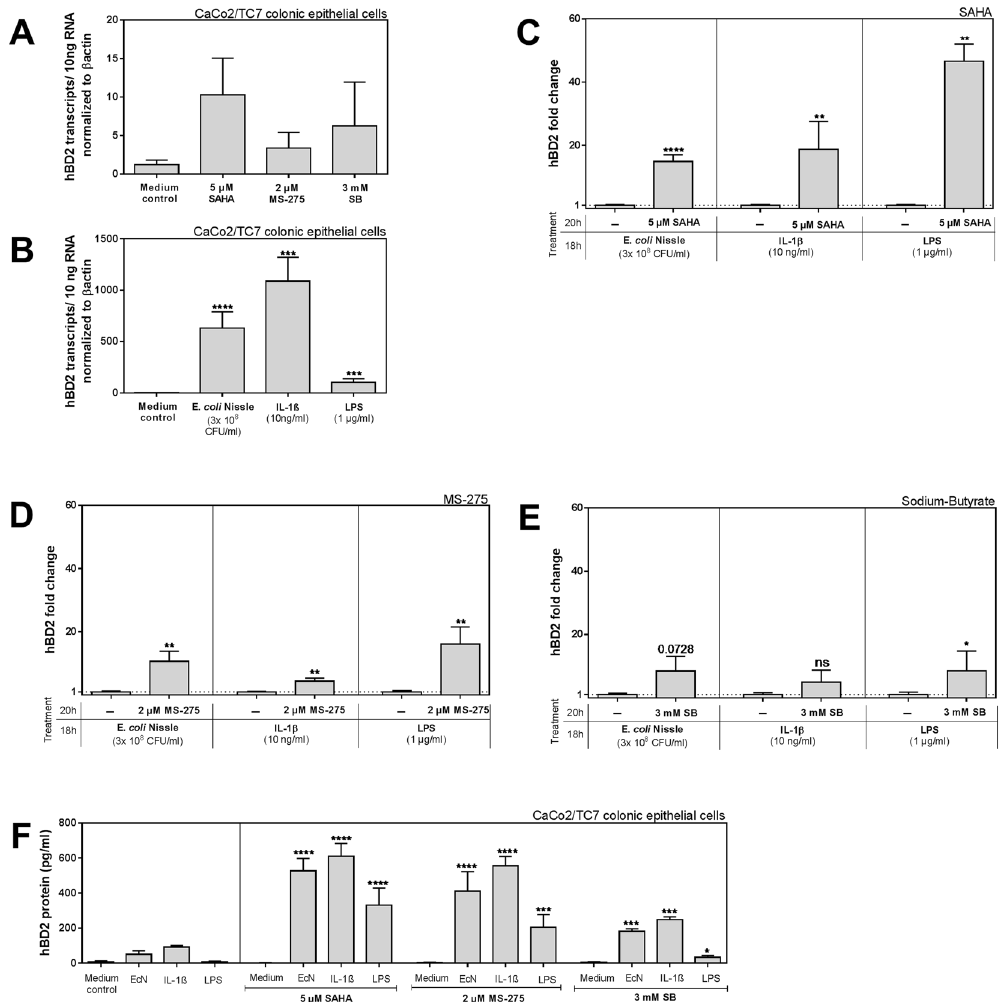
Figure 1. Enhancing effect of histone deacetylase (HDAC) inhibition on the induction of human β -defensin 2 (hBD2) in CaCo-2/TC7 cells in response to E. coli Nissle 1917 (EcN), Interleukin 1 β (IL-1 β ) and lipopolysaccharide (LPS). HBD2 mRNA expression after ( A ) treatment with HDAC inhibitors SAHA (5 µ M), MS-275 (2 µ M) or SB (3 mM) each for 20 hrs or ( B ) with the probiotic strain E. coli Nissle 1917 (3 × 10 8 CFU/ml), IL1 β (10 ng/ml) or LPS (1 µ g/ml) each for 18 hrs. Shown are relative copy numbers of hBD2 per 10 ng total RNA normalized to β actin expression. ( C–E ) Shows the fold change in hBD2 induction compared to each stimulation alone when co-treated with either SAHA (5 µ M) ( C ), MS-275 (2 µ M) ( D ) or SB (3 mM) ( E ). Here inhibitor treatment started 2 hrs prior to the stimulations, which took then place in parallel to HDAC inhibition for another 18 hrs. Shown are results of at least three independent experiments carried out in biological triplicates. * p < 0.05, ** p < 0.01, **** p < 0.0001 evaluated by Mann-Whitney u test. ( F ) HBD2 peptide levels from CaCo-2/TC7 cell lysates as determined by ELISA. Treatment was carried out exactly as for mRNA analyses. Results represent three independent experiments measured as technical triplicates. * p < 0.05, *** p < 0.001, **** p < 0.0001 evaluated by Mann-Whitney u